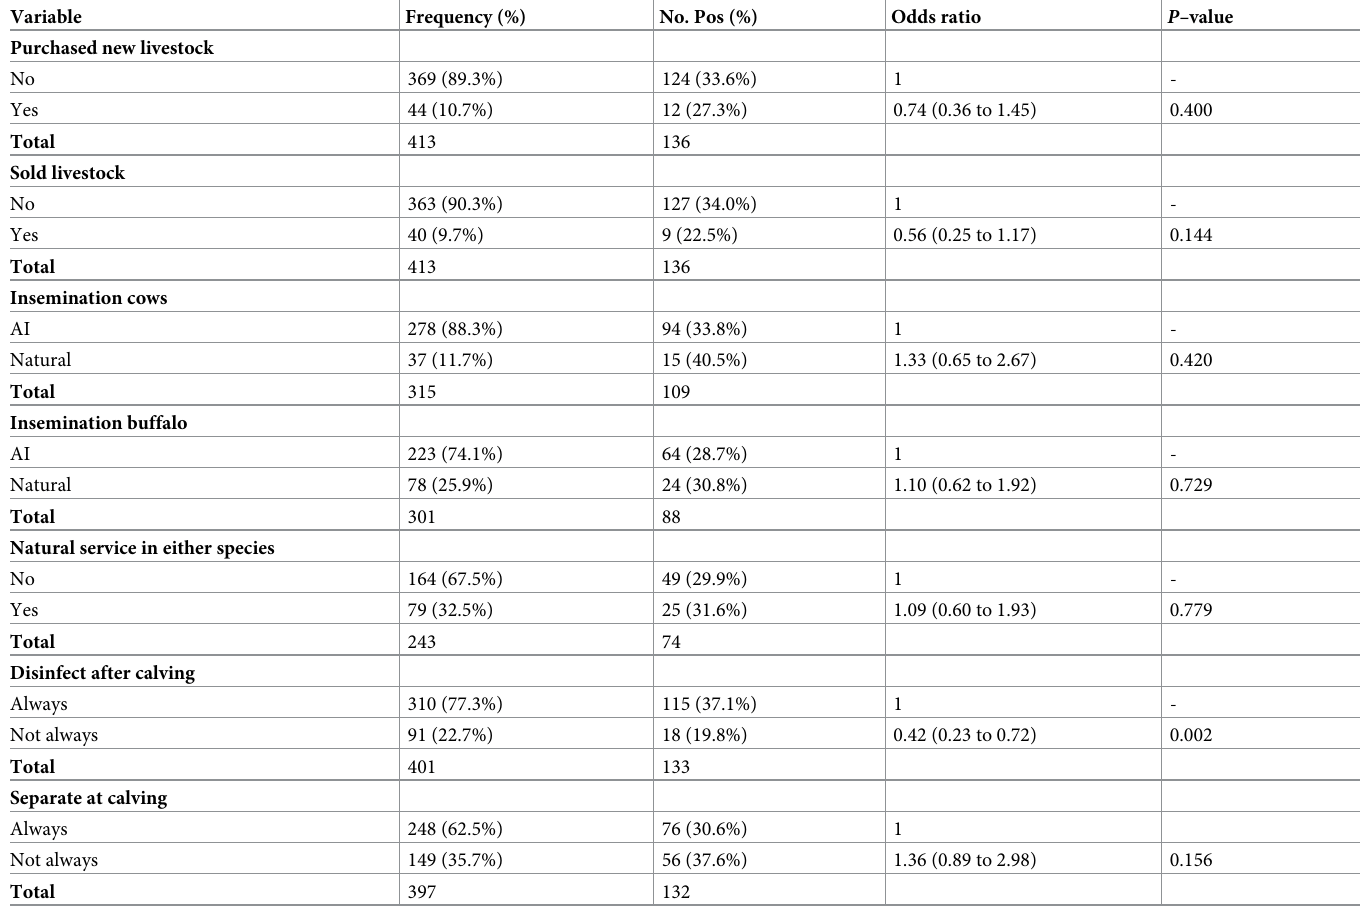
Table 3. Herd-level univariate analysis for associations between herd management and at least one animal in the herd testing seropositive, using logistic regression with village included as a random effect. Variable